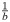
Modeling metastasis formation process and its bottleneck.a Three phases of metastasis formation. In phase 1, tumor cells are constantly released into the blood stream. Given that larger tumors can release more cells over time, they have a higher chance to develop metastases. Thus, a dependency of metastasis probability and patient outcome on tumor size is expected. The bottleneck is the metastasis initiation in phase 2. b Stochastic birth-and-death process of metastasis initiation. For each cell in the forming colony, the ratio of its proliferation rate λi to its death rate μi depends on the total number of cells i with a proportionality constant 1b. c The bottleneck severity b is the critical colony size for metastasis initiation. The probability of colony survival starting from i cells is lower than 0.5 (gray horizontal line) when i < b and larger than 0.5 when i > b, and increases rapidly when i crosses b. b = 17, red, is the most common median bottleneck estimated for cancers we analyzed (Fig 4d). d Model parameters on a timescale. From tumor onset to diagnosis, the tumor grows and releases cells. Once a metastasis is successfully initiated, it takes a cancer-specific average number of years δ0 until it becomes lethal. The initiated metastases grow on average δ1 years to become large enough to be detectable by screening. With a certain probability, decreasing with metastasis age, and parametrized by the expected age a when metastases become irremovable, treatment may remove metastasis. Also due to treatment, time to death is prolonged by a constant h.